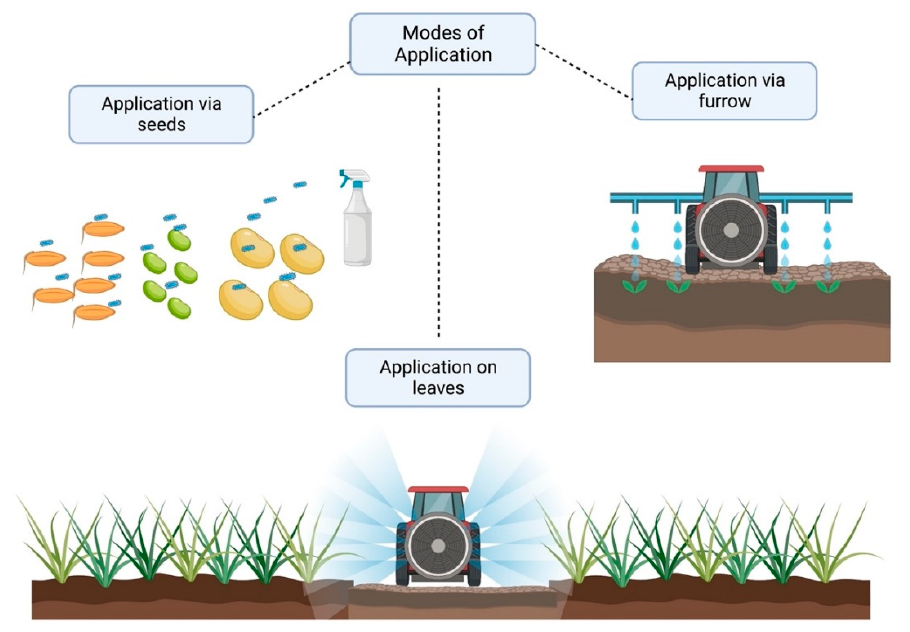
Figure 3. Modes of application of PGPR.